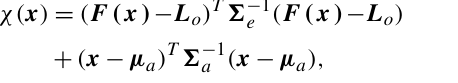
Figure 3. The relative sensitivity to water vapor at 4km acquisition altitude in a tropical atmosphere as a function of horizontal distance from nadir, partitioned by solar zenith angle θ s .